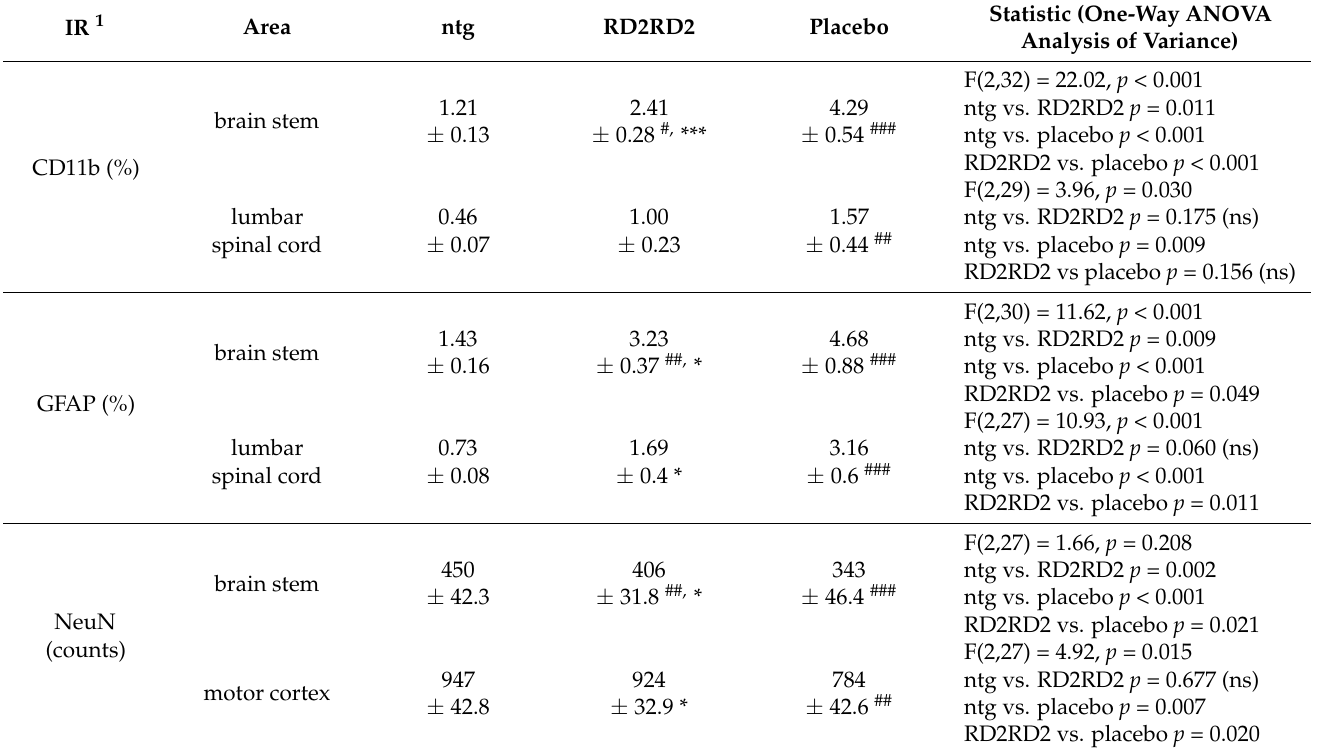
Table 1. Evaluation of immunolabelling in brain and lumbar spinal cord of SOD1*G93A mice revealed a decrease of gliosis after treatment with RD2RD2. Data is presented as mean ± SEM. Statistical calculations were conducted by one-way ANOVA with Fisher’s LSD post hoc analysis. Lozenges ( # ) and asterisks (*) indicate a significance between treatment groups (ntg vs. RD2RD2 or ntg vs. placebo: # p = 0.05, ## p = 0.01, ### p < 0.001 and RD2RD2 vs. placebo: * p = 0.05, *** p <